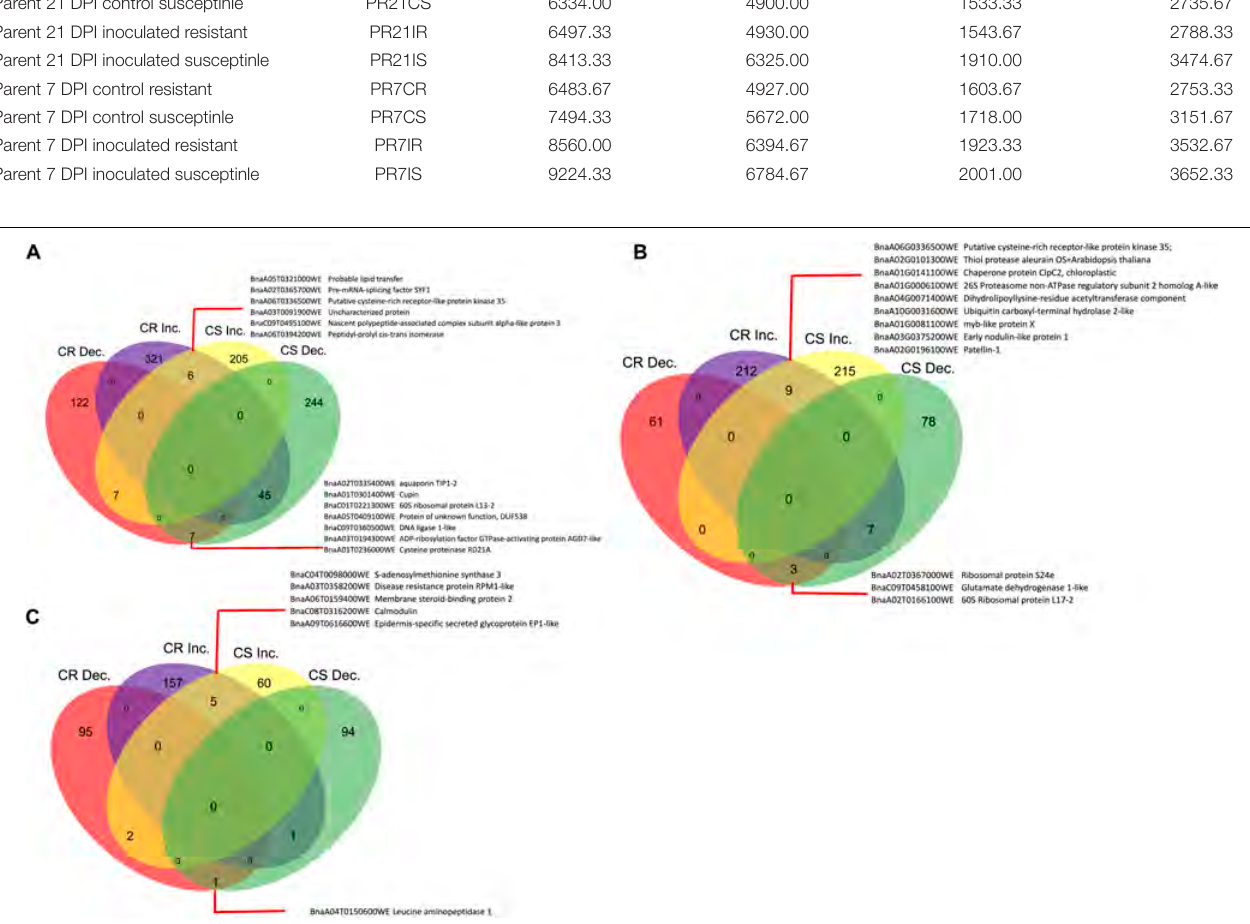
FIGURE 4 | Differentially accumulated proteins (DAP) between control (CC) and inoculated (In), In/CC CR and In/CC CS in the progeny lines. The numeric values indicate the number of proteins that were significantly changing in abundance ( q -value < 0.05) in protein abundance. (A) 7 DPI, (B) 14 DPI, and (C) 21 DPI. CR, clubroot resistant; CS, clubroot susceptible; Inc and Dec represent Increase and Decrease; respectively.